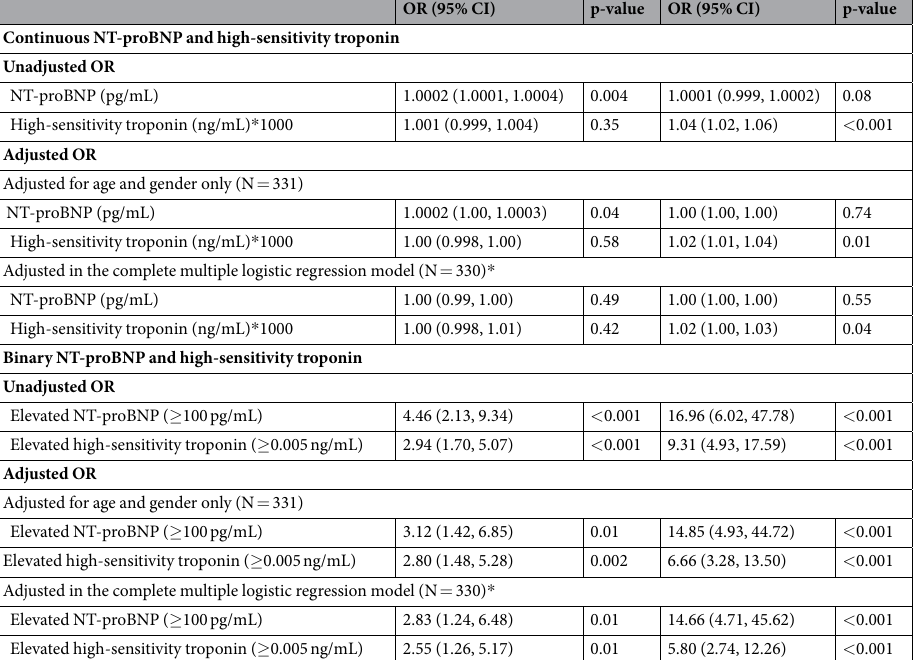
Table 2). Through Bayesian model averaging, age, sex, black ethnicity, history of diabetes, use of diuretics, and use of statin medications were selected for inclusion into a multivariable logistic regression model for the tendency to have elevated ECV or scar presence. In unadjusted models, increasing categories of NT-proBNP and hs-cTnT were associated with elevated ECV and scar presence (Tables 5 and 6). After adjustments for selected covariates as described, this association was maintained for elevated ECV (highest vs. lowest categories of hs-cTnT odds ratio [OR] 2.43 [95% confidence interval (CI) 1.01, 5.84], p = 0.047; highest vs. lowest categories of NT-proBNP OR 3.32 [95% CI 1.35, 8.12], p = 0.01) and even more so for scar presence (highest vs. lowest categories of hs-cTnT